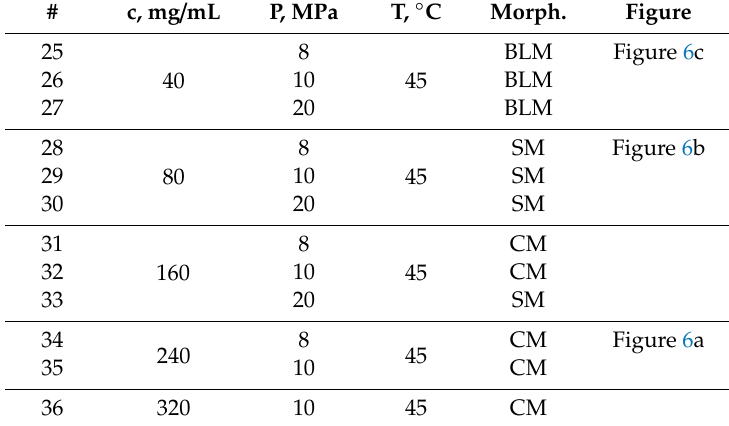
Table 2. List of the performed experiments using supercritical phase inversion. CM: cellular membrane; SM: spinodal membrane; BLM: beads-like membrane.